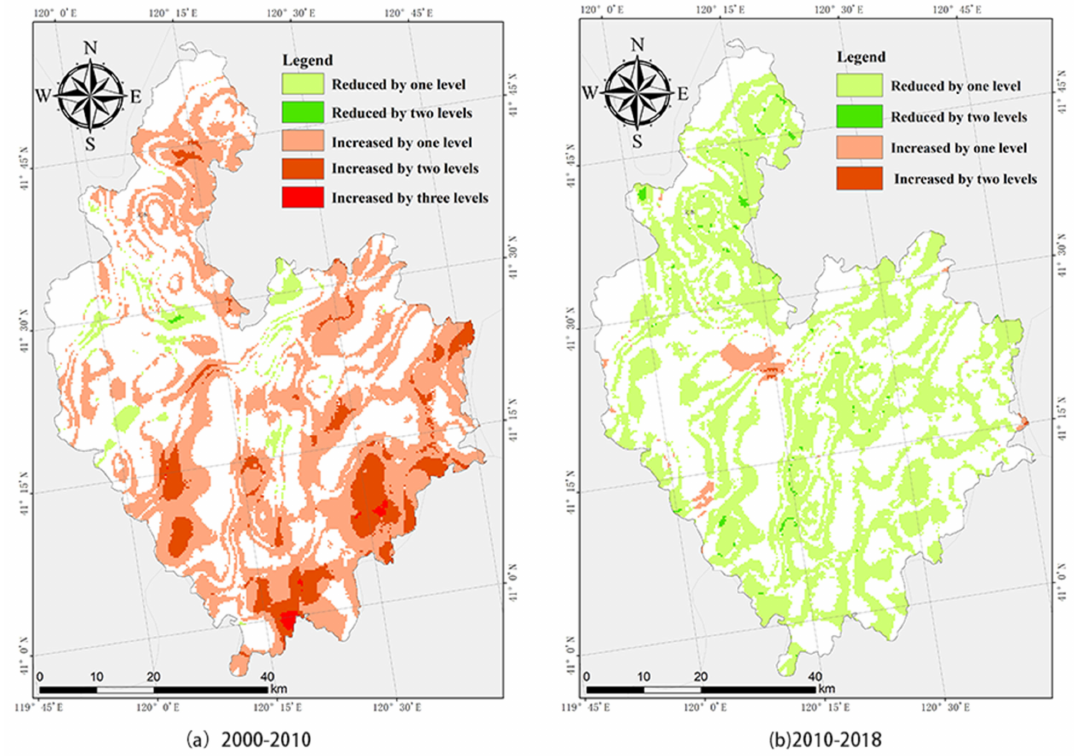
Figure 6. Changes in landscape ecological risk levels in Chaoyang County in ( a ) 2000–2010, ( b )